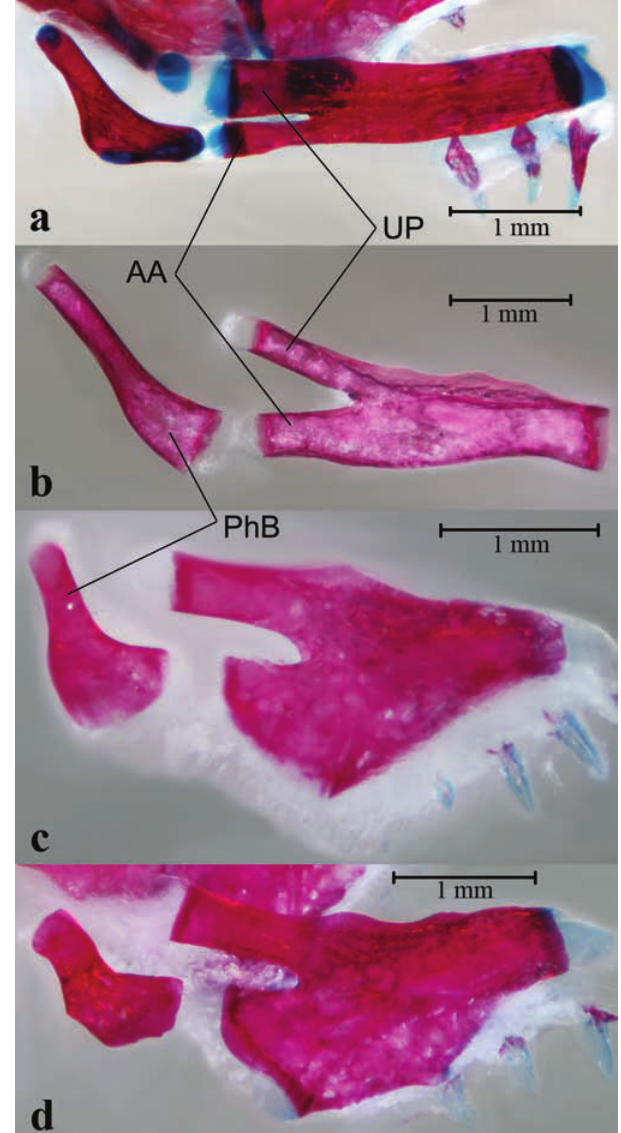
Fig. 3. First epibranchial and pharyngobranchial bones in right, approximately antero-dorsal view illustrating morphological phylogenetic characters 100 and 101; a ) Guianacara dacrya , character states 100-0, 101-0, 58.0 mm SL, ANSP 179495; b